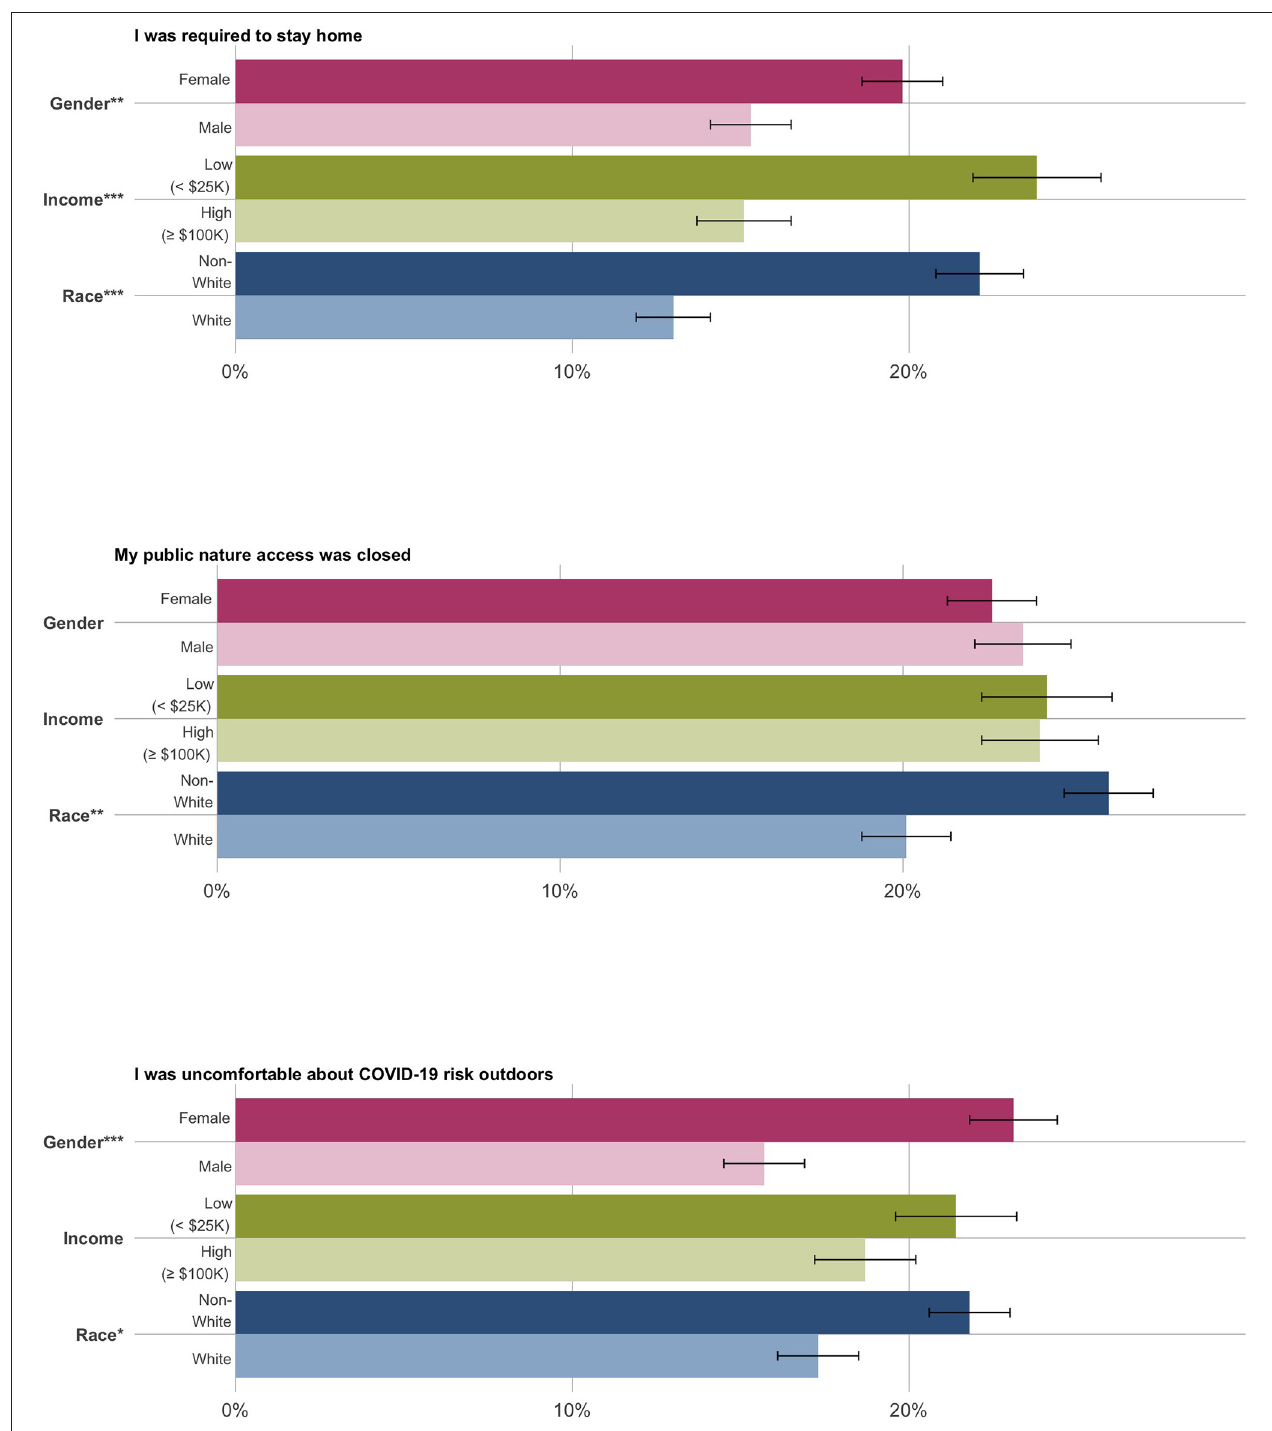
FIGURE 5 | Perceptions of nature-related COVID restrictions and risks by demographic group. Error bars represent SE of the mean. Significance is from chi-squared tests within demographic group for each statement. * p < 0.05, ** p < 0.01, *** p < 0.001. at home [16%, 95% CI (10, 21%)], closed public parks Perceptions of nature-related COVID restrictions and risks [9%, 95% CI (4, 14%)], and discomfort with the risks were associated with reported changes in time spent in nature. Less nature was associated with requirements to stay